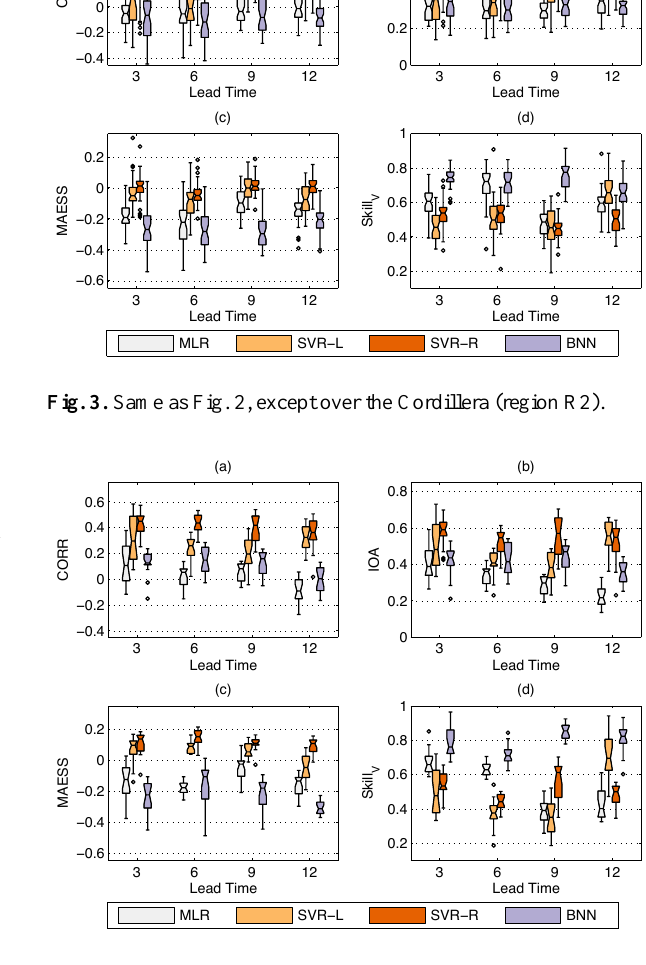
SVR-R did best among the four models, outperforming cli- matological forecasts due to its positive MAESS values. In Skill V (Fig. 4d), again BNN forecasted anomalies with stan- dard deviations most similar to those observed, however, the BNN forecasts are unimpressive in terms of the CORR, IOA and MAESS scores. Overall, among all 6 regions, this region shows the highest forecast scores and the clearest advantage of incorporating nonlinearity in the models. Using canonical correlation analysis to forecast Canadian winter mean sea- sonal climate, Shabbar and Barnston (1996) also found the highest skills manifested in the